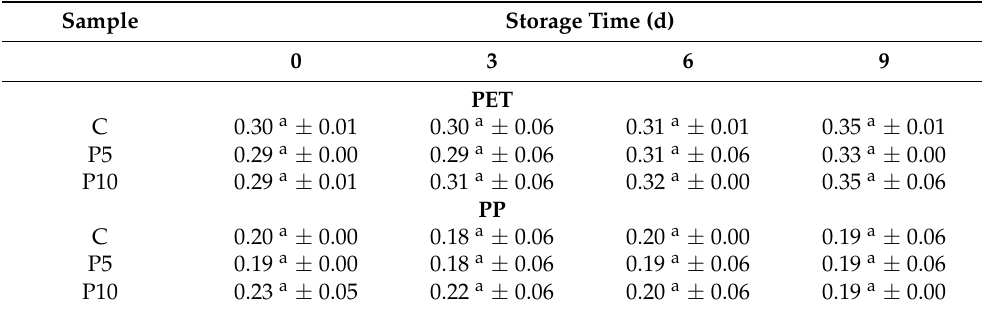
Table 6. Titratable acidity (g/100 g) of apples packaged in PET and PP after 5 (P5) and 10 (P10) min of CAP treatment compared with the control (C) sample during 9 days of storage at 8 ◦ C. Sample Storage Time